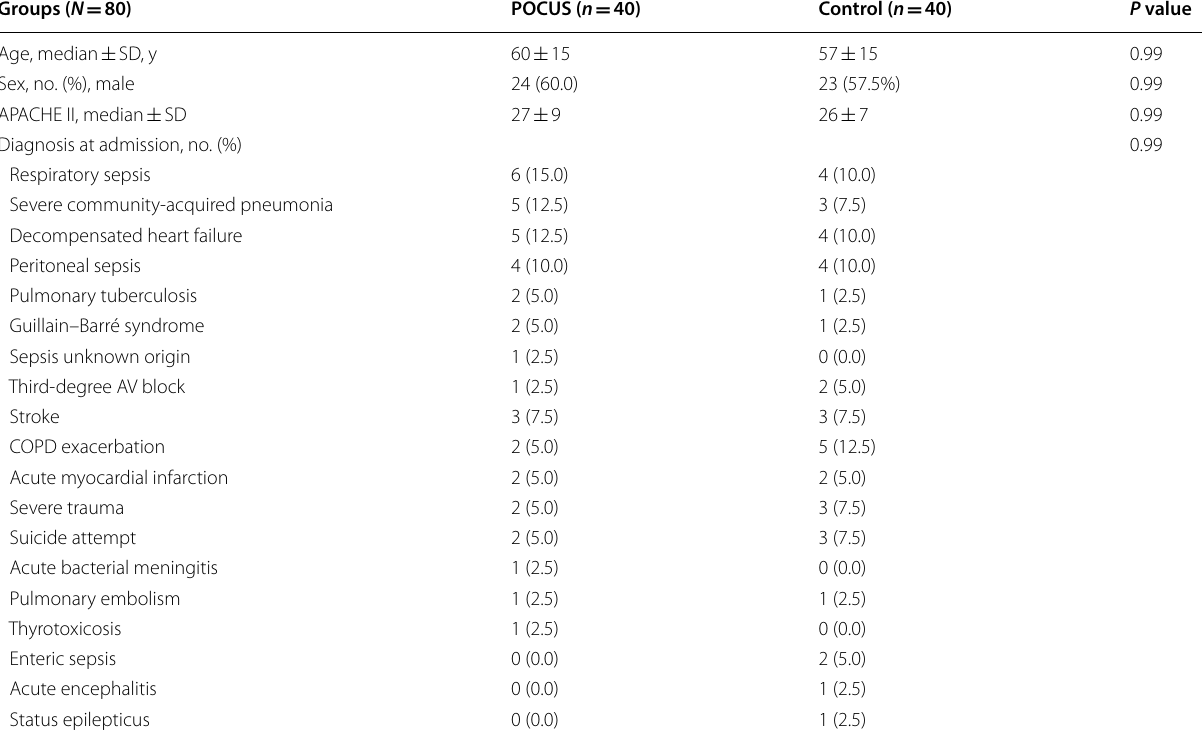
Table 2 Demographic data and diagnosis at admission in each group